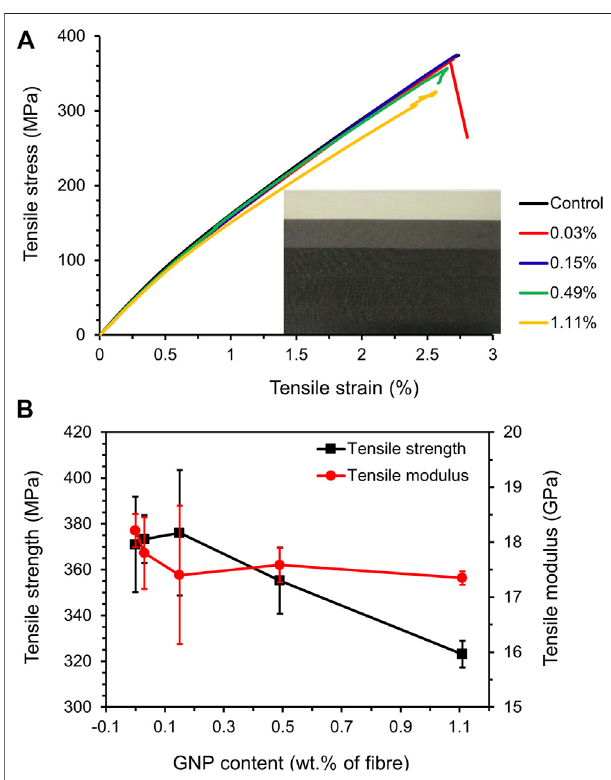
FIGURE 7 | (A) Representative tensile stress – strain curves embedded with photos of samples with different GNP loadings. (B) Tensile strength and modulus of the